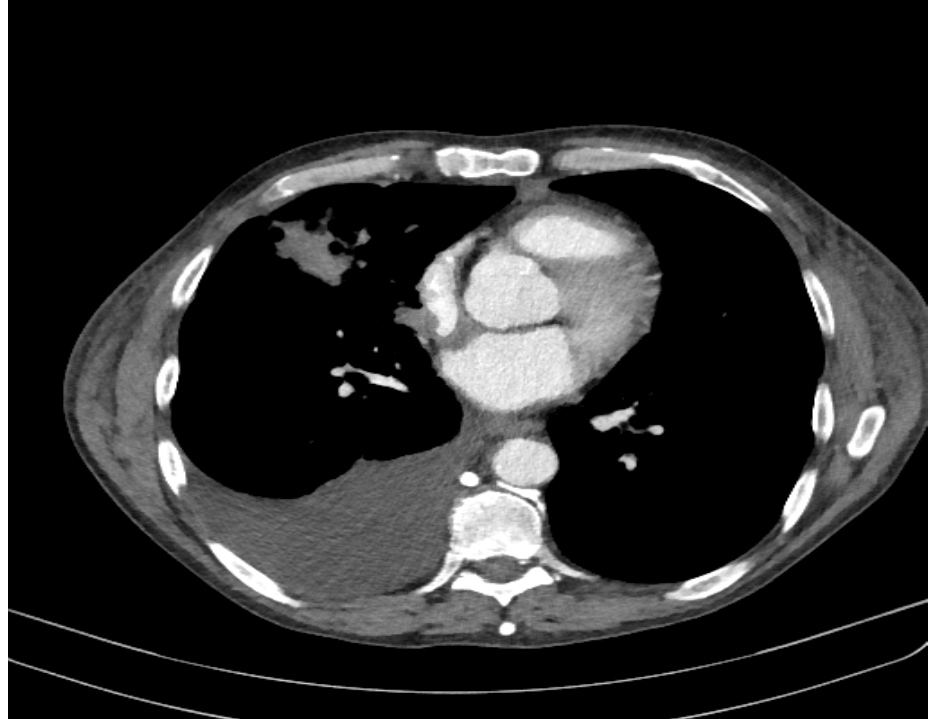
Figure 7. Computer tomography of the patient.